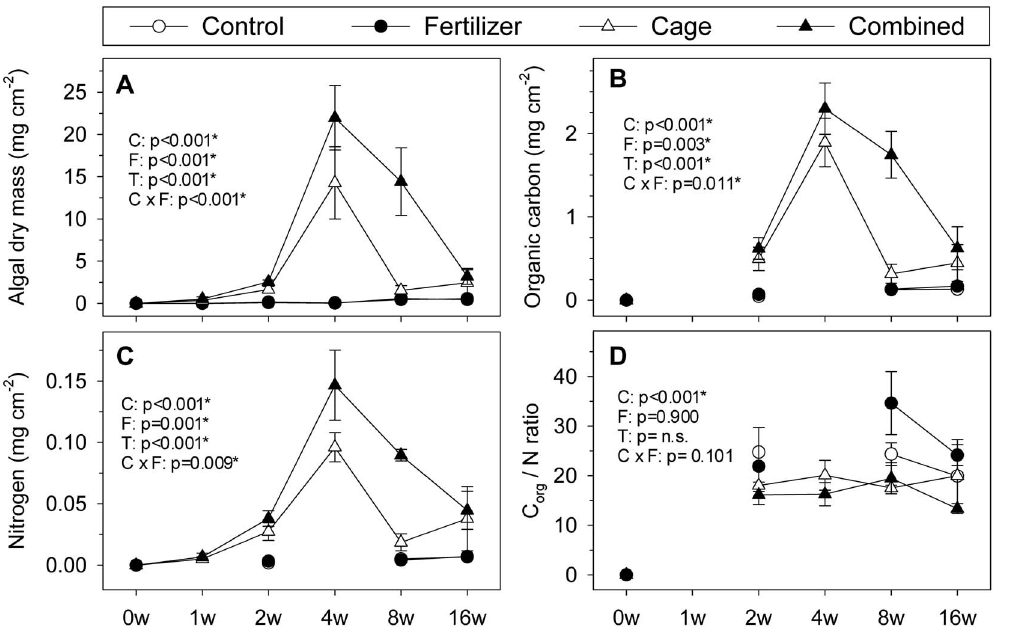
Figure 3. Development of algal dry mass (A), organic carbon (B), nitrogen content (C), and organic C / N ratio (D) on light-exposed tiles. Shown are means 6 SE of all treatments in mg cm 2 2 over the 5 sampling points after 1, 2, 4, 8 and 16 wk(s). P-values were calculated from a 3- factorial ANOVA and originate from analysis across the whole study period (see Table 1 for full results). P-values were tagged as n.s. (=not significant), when the model reduction step excluded the corresponding factor(s). Missing connections between data points are due to insufficient algal material for analysis. Abbreviations: C=Cage, F=Fertilizer, T=Time.